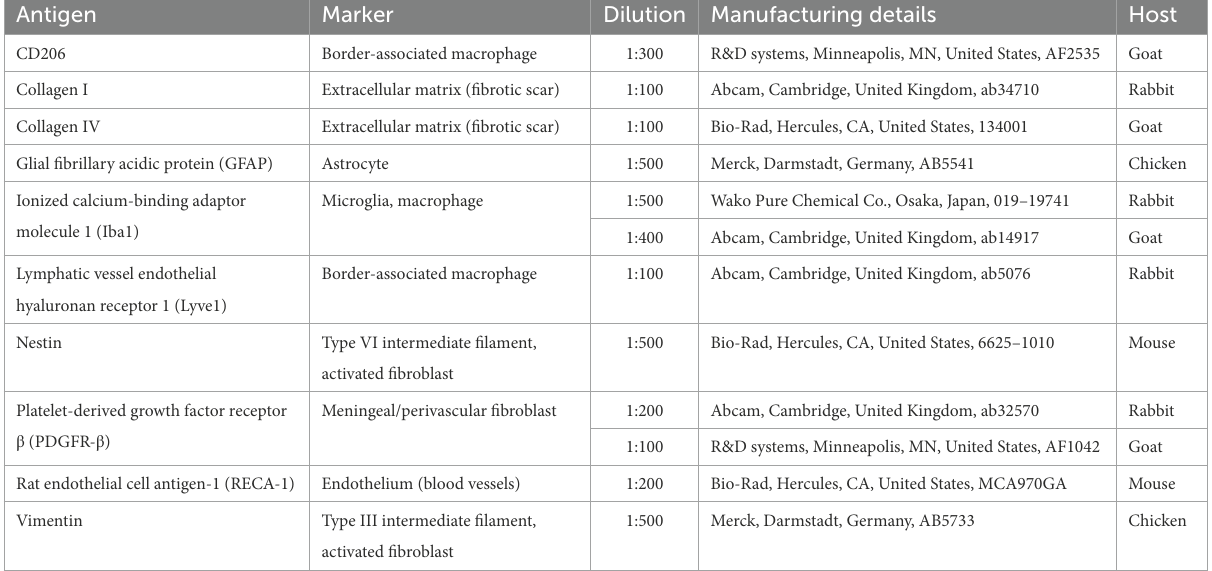
TABLE 1 Details of primary antibodies